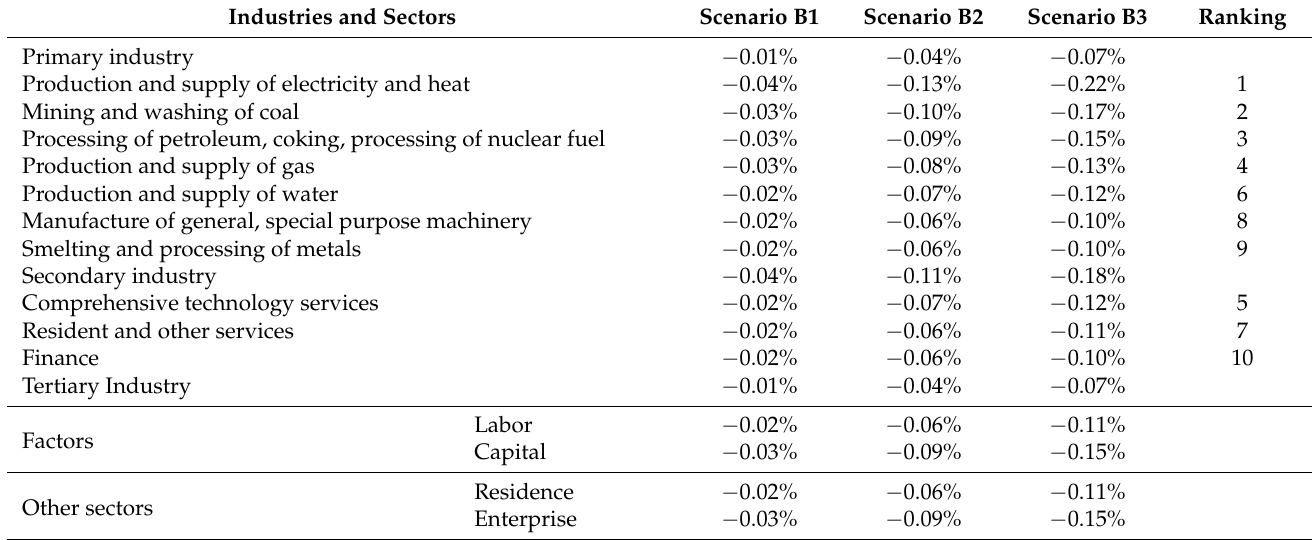
Table 6. Output and income changes of various industries and sectors based on restricting oil and gas